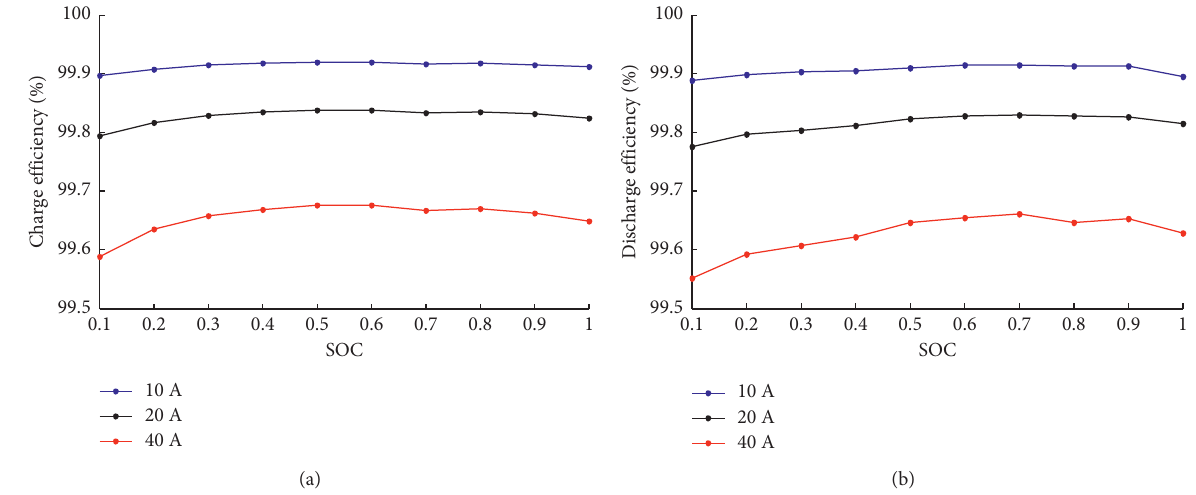
Figure 3: (a) Charge efficiency of battery. (b) Discharge efficiency of battery.